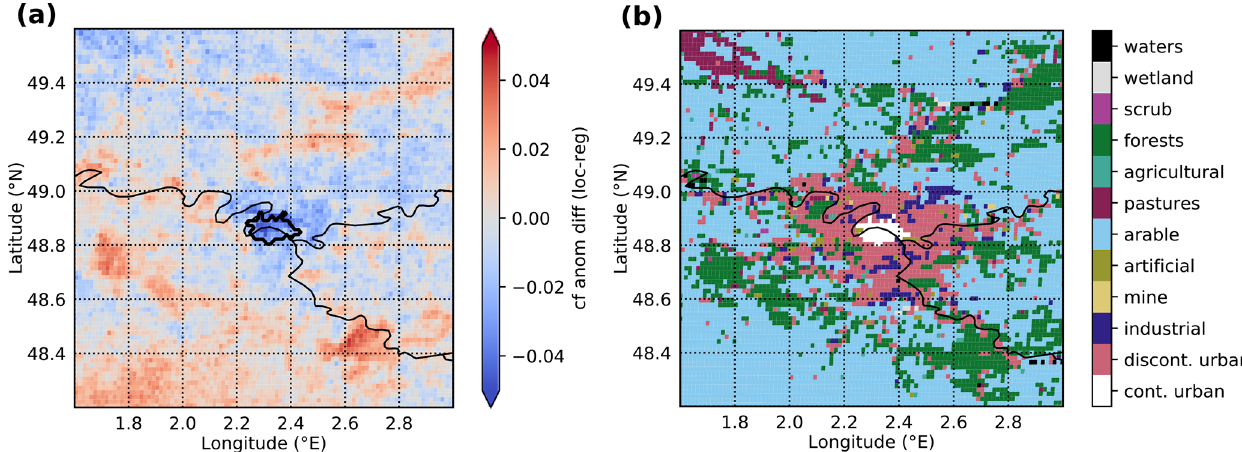
Figure 4. (a) Difference between cloud fraction anomalies (CF loc anomaly − CF reg anomaly) from local and regional empirical cloud detection approaches. (b) Main CORINE land cover classes L2 and L3 for the year 2012. Larger rivers are visualised as black lines.